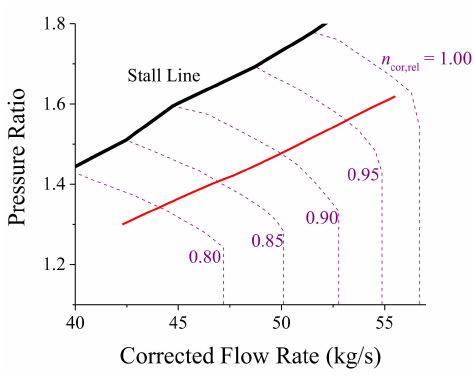
Figure 19. The Matched Operating Line of AFS ( bpr 2 =